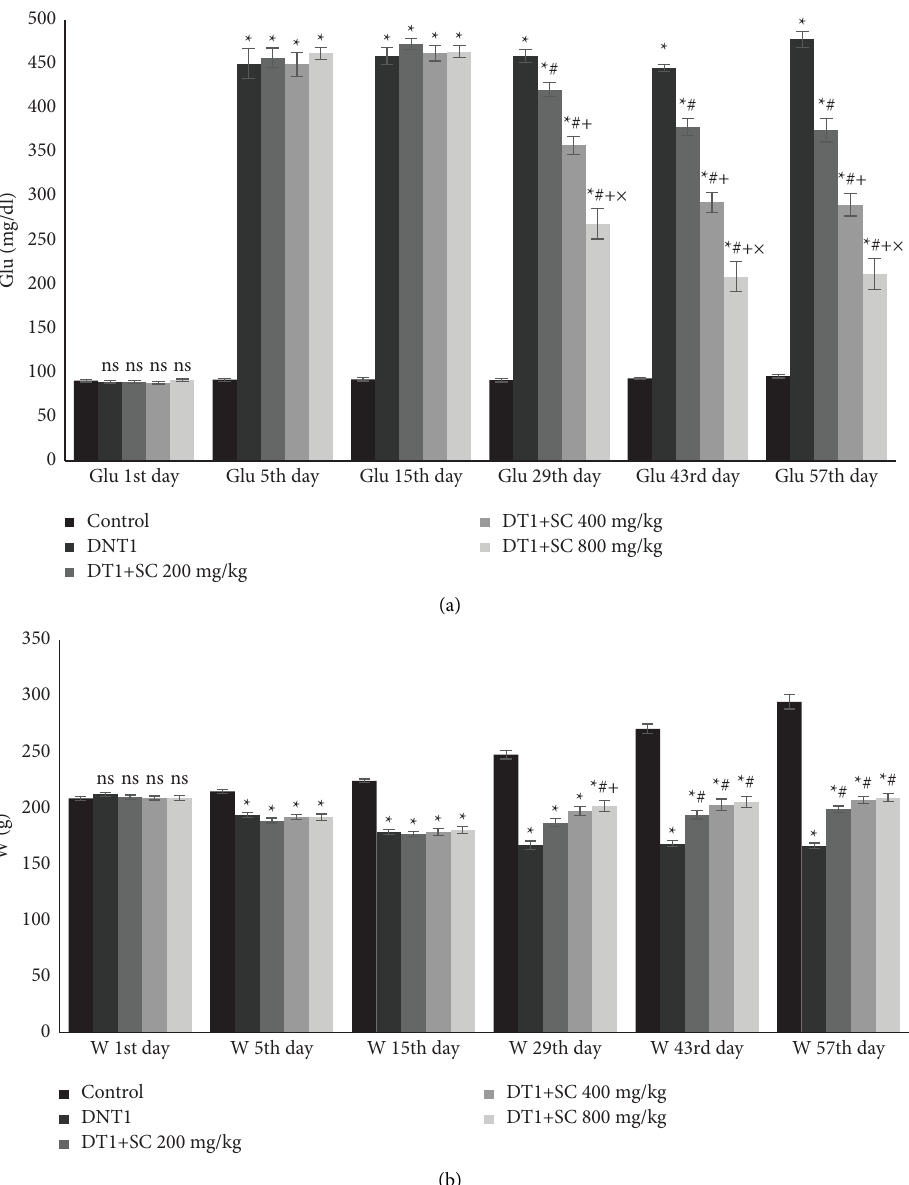
Figure 1: Blood glucose and body weight of animals during the study. (a) Mean glucose level and (b) mean body weight. Significant differences at p value < 0.05 are shown as not having a common character. Values are shown as mean ± SEM. ns: nonsignificant between groups, star sign ( ∗ ): difference with control, hashtag sign (#): difference with DNT1, plus sign (+): difference with DT1+SC200 mg, multiplication sign ( × ): difference with